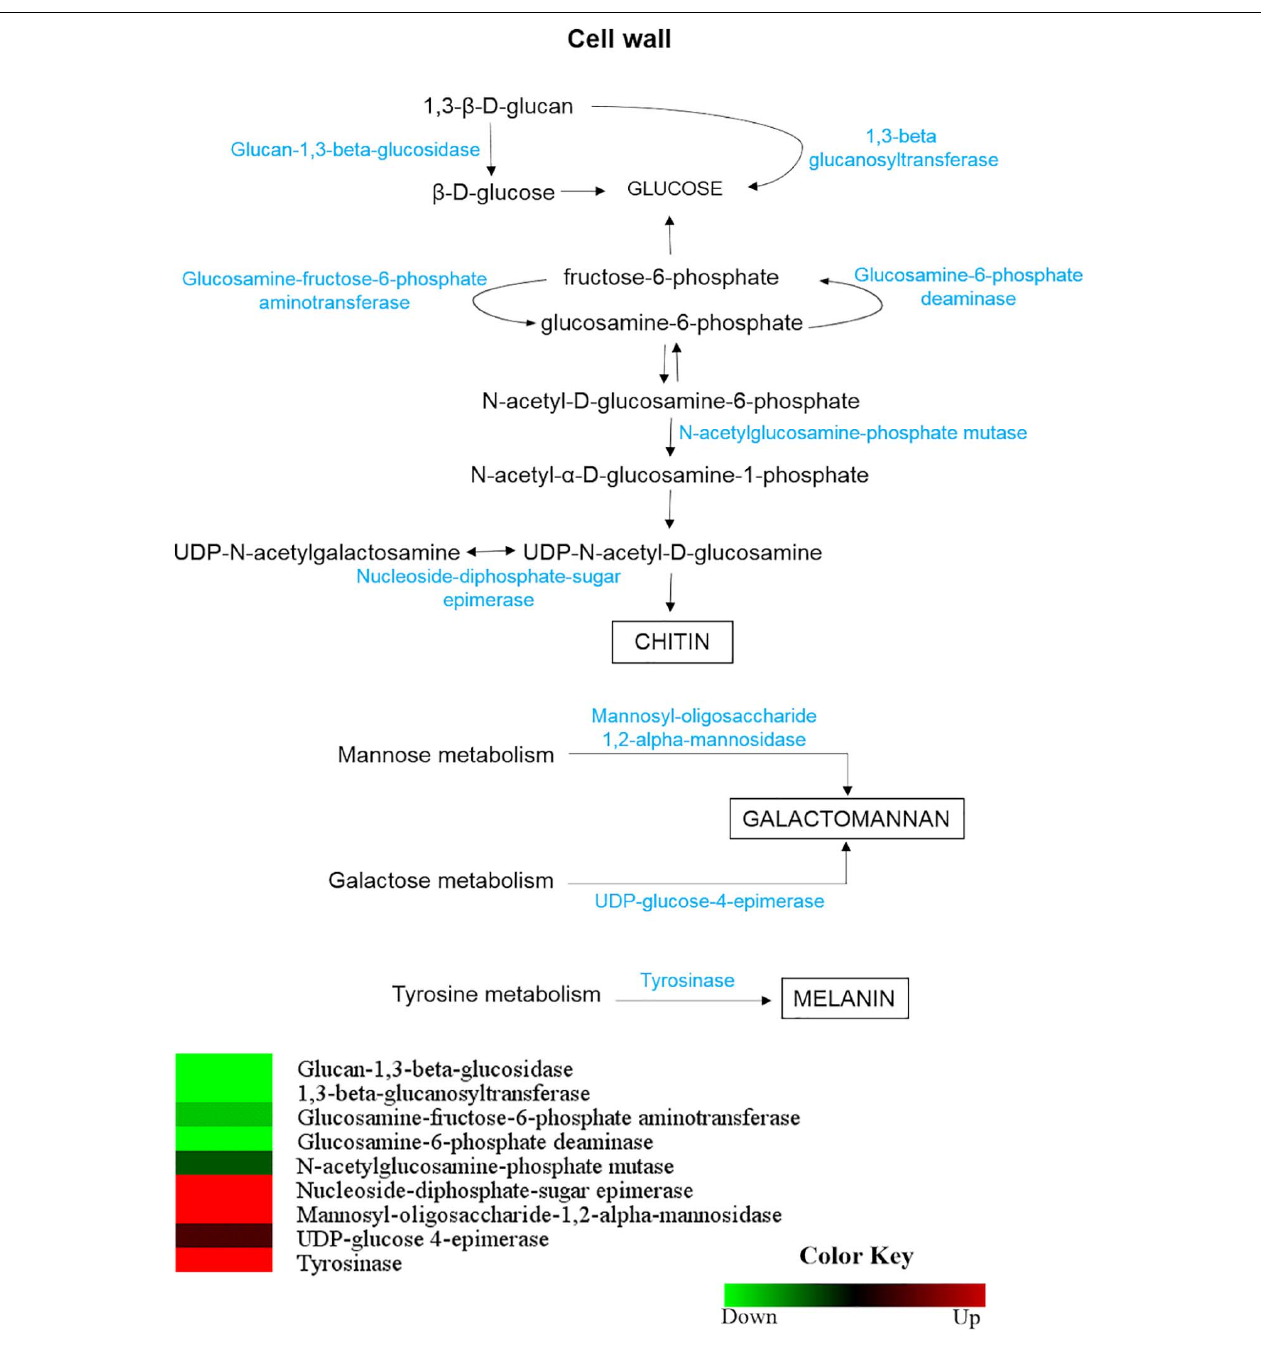
FIGURE 7 | Comparison of protein profiles related to the metabolism of compounds present in the H. capsulatum mycelium and yeast forms the cell wall. Dataset comparisons were carried out as cited in the Figure 2 legend. Changes in the abundance levels in the mycelium compared with the yeast are represented in the heat map. Experimental triplicate mean values are presented for the lowest (green) and the highest (red) abundance of H. capsulatum proteins in the mycelium form. Black indicates that no significant difference was